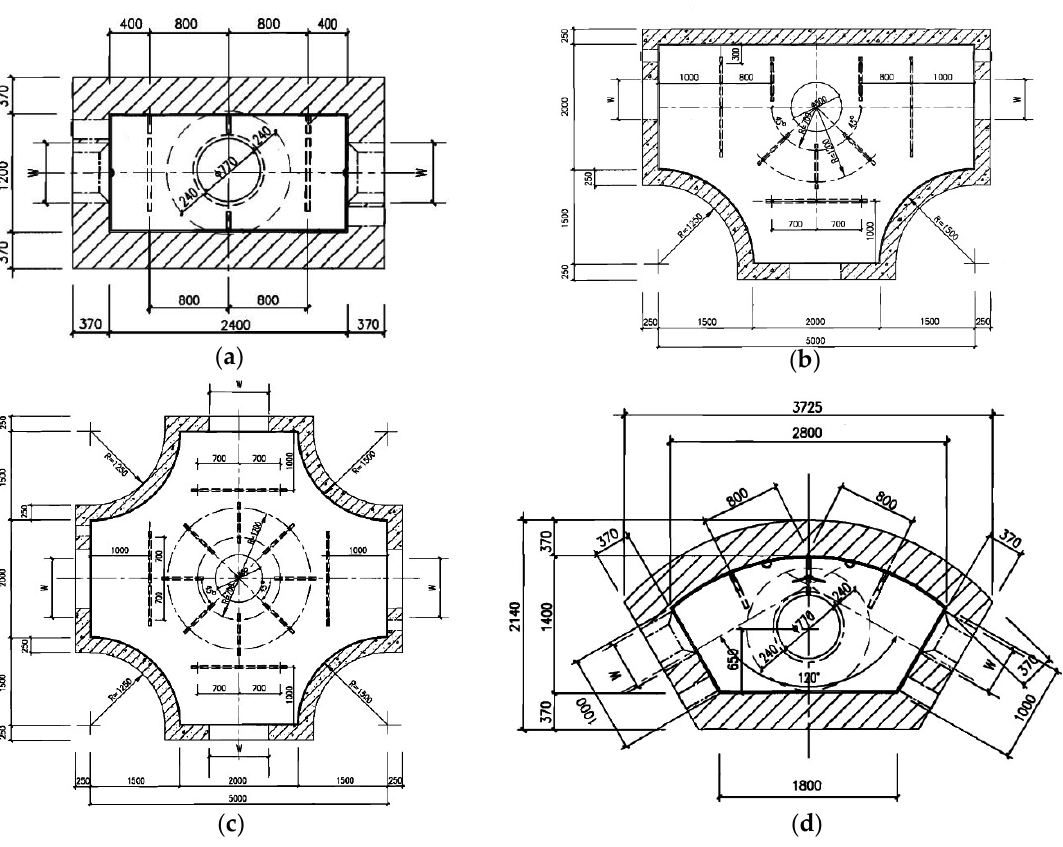
Figure 2. Types of underground cable wells. ( a ) Straight-through, ( b ) Three-way, ( c ) Four-way, and ( d ) Corner.